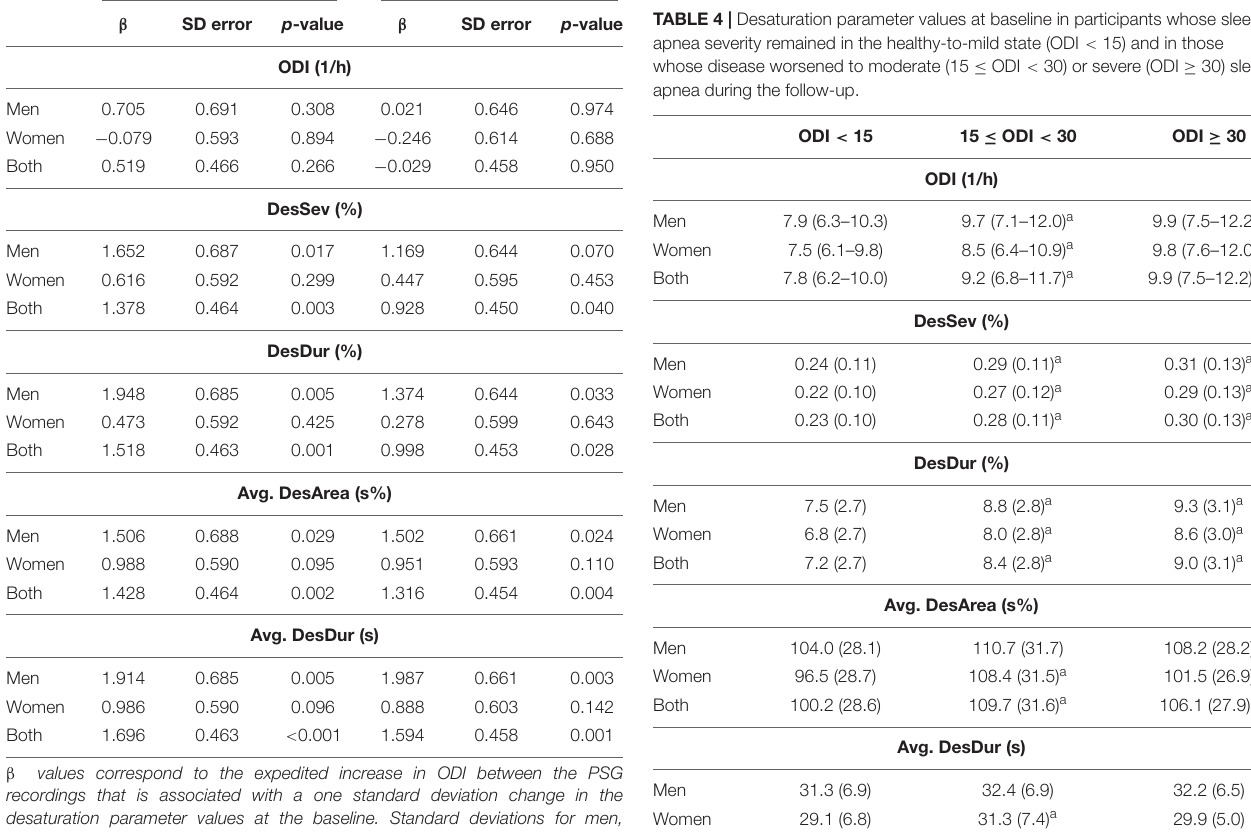
TABLE 3 | Linear regression analyses for the estimation of mild sleep apnea progression based on the desaturation parameter values at the baseline. Unadjusted Adjusted a SD error p -value β SD error TABLE 4 | Desaturation parameter values at baseline in participants whose sleep apnea severity remained in the healthy-to-mild state (ODI < 15) and in